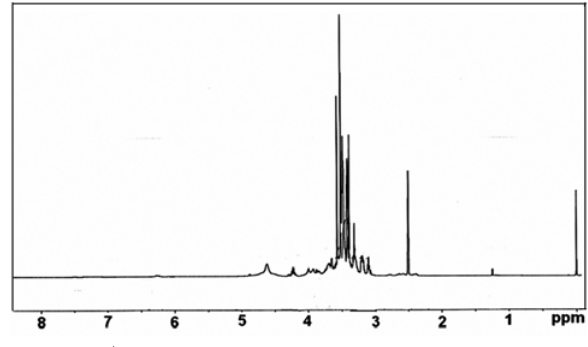
Fig. 3. 1 H-NMR spectrum of oligoetherol obtained from mMPP:EC=1:22